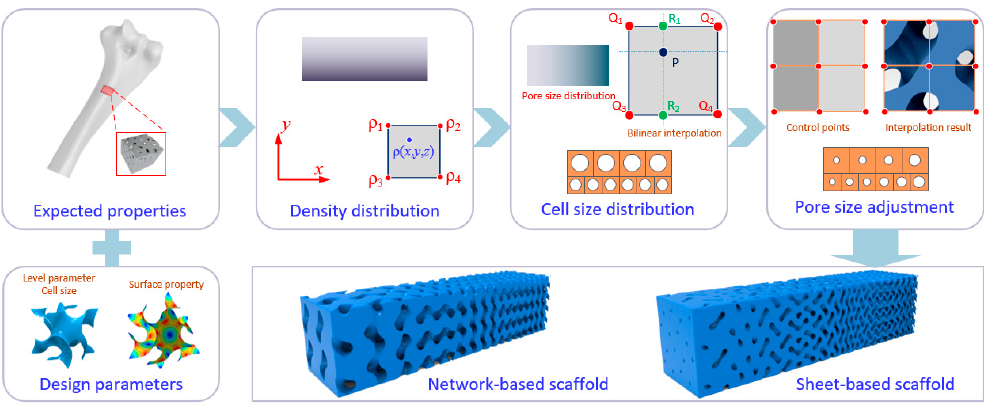
Figure 3. Procedure of the generation of FGS based on the expected properties with programmable pore size.